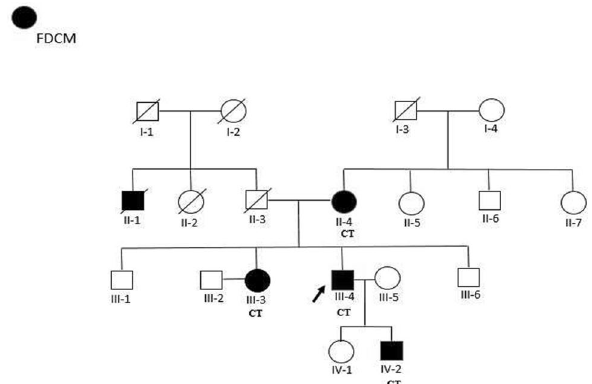
Figure 1. The Pedigree of a family suffering early-onset FDCM. WES was performed for III-4 (proband); a novel heterozygous variant (c.985C > T, p.H329Y) in GATA6 was identified in the III-4, IV-2, III-3, and II-4 patients. Healthy individuals (non-affected such as III-1 and III-5) had normal genotype (CC). Deceased members are shown by slashes. Solid symbols are indicating the family members diagnosed with FDCM. Genotypes are shown as: Wile-type allele = C , Mutant allele = T.